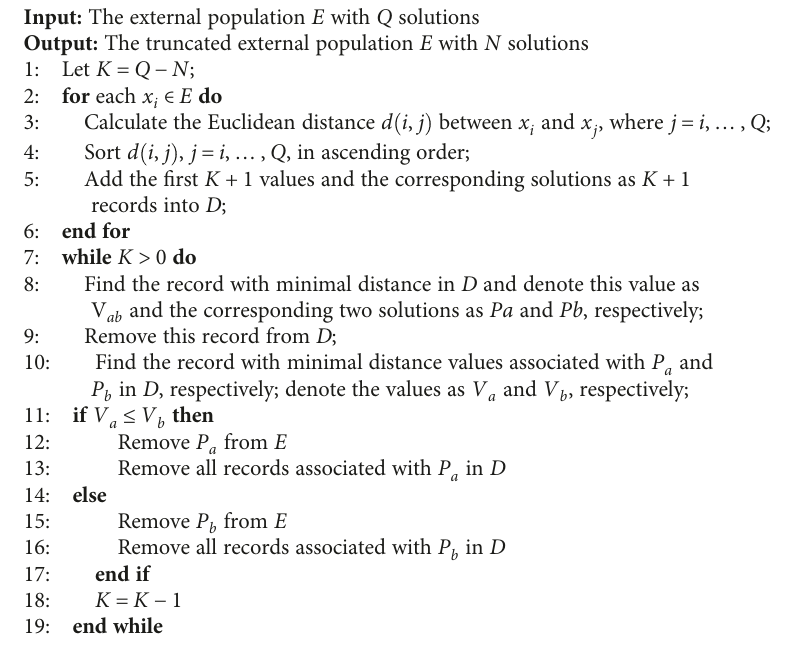
Algorithm 2: The main truncating process by the CCE